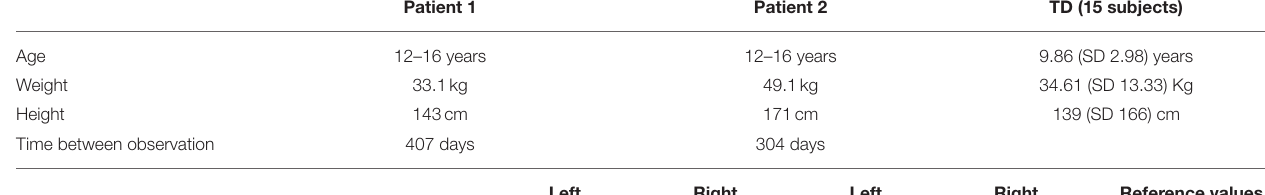
TABLE 1 | Subjects demographics and data from clinical